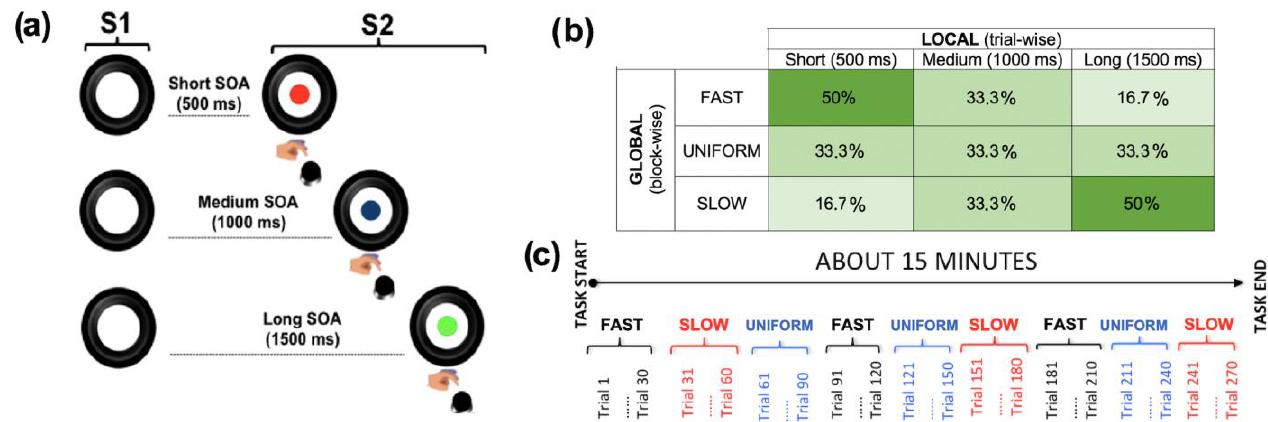
Figure 1. Representation of the DTP task. ( a ) Trial structure. The circle (S1) warned children on the forthcoming presentation of the imperative S2 stimulus (an animal cartoon; here represented with colored disks for illustrative purposes). Participants had to make speeded reaction times at S2 onset by pressing the space button on the keyboard. The effect of local prediction was assessed by manipulating S1–S2 stimulus onset asynchrony (SOA) within each experimental block, generating three fixed intervals of 500 ms, 1000 ms and 1500 ms. ( b ) Experimental Design. The effect of global prediction was assessed by manipulating the between-block a priori percentage of each SOA to create three probabilistic distributions in which the SOAs were skewed toward the short (fast block), equally distributed (uniform block) or long (slow block) SOA. ( c ) Task design. A total of 9 blocks were delivered. Each block included 30 trials, for a total of 270 trials. The block order was randomized between-subjects. The picture shows an example of possible order